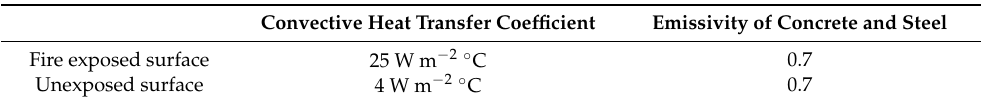
Table 3. Radiative and convective heat transfer coefficients and emissivity for exposed and unexposed surfaces of concrete and